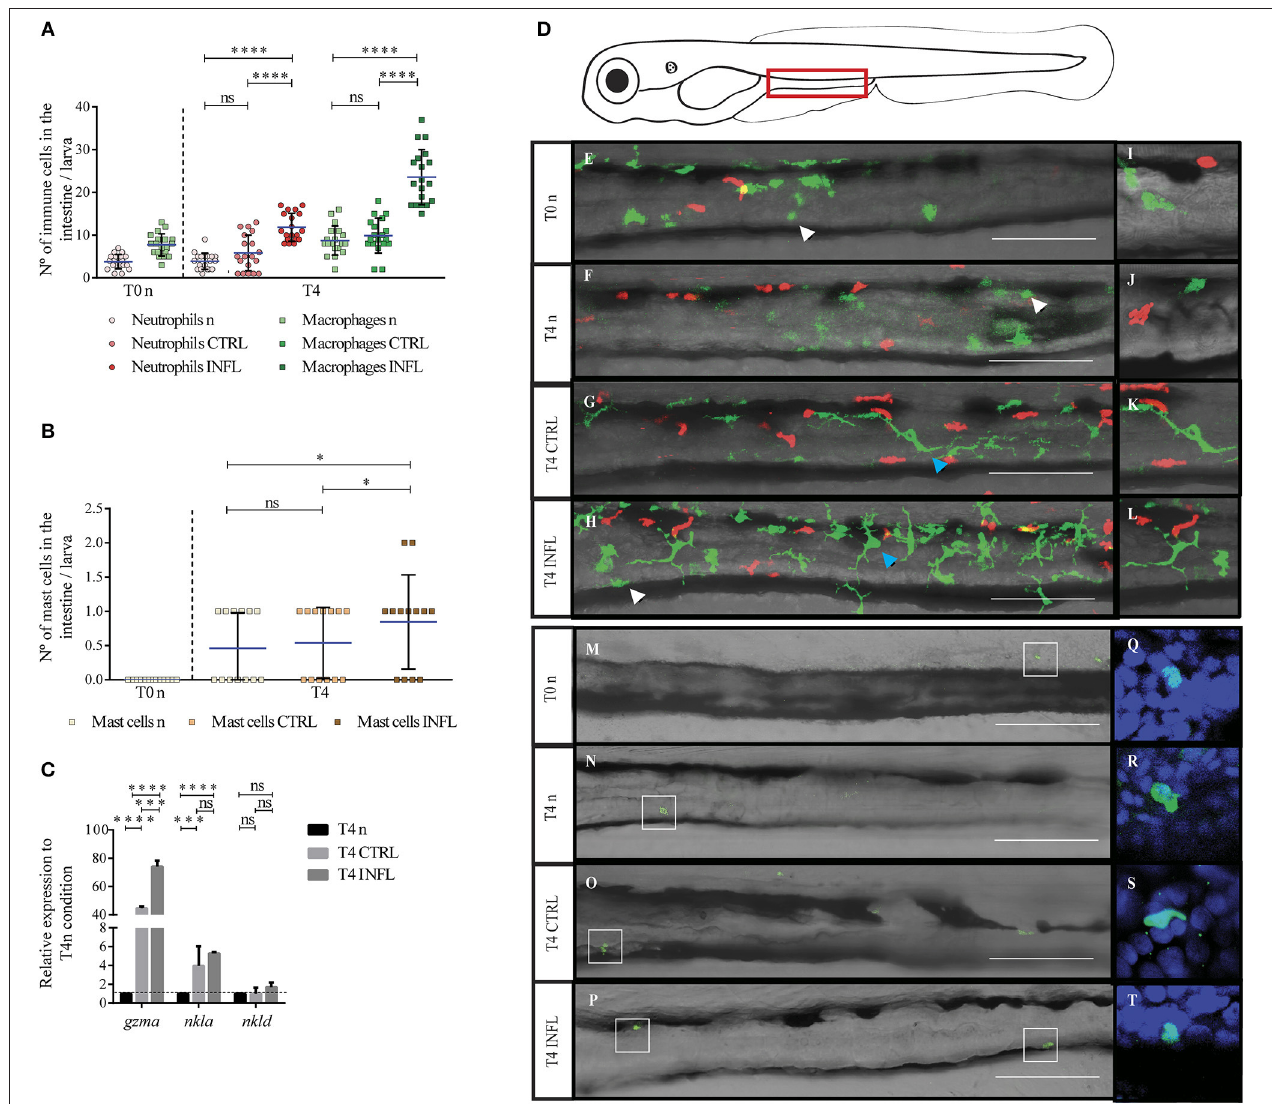
FIGURE 1 | Neutrophils, macrophages, and mast cells increase their presence in the gut during the inflammatory process triggered in the naïve feeding model. The number of neutrophils/macrophages (A) , and mast cells (B) was quantified under different conditions (n, naïve; CTRL, control; INFL, inflammation) and time points